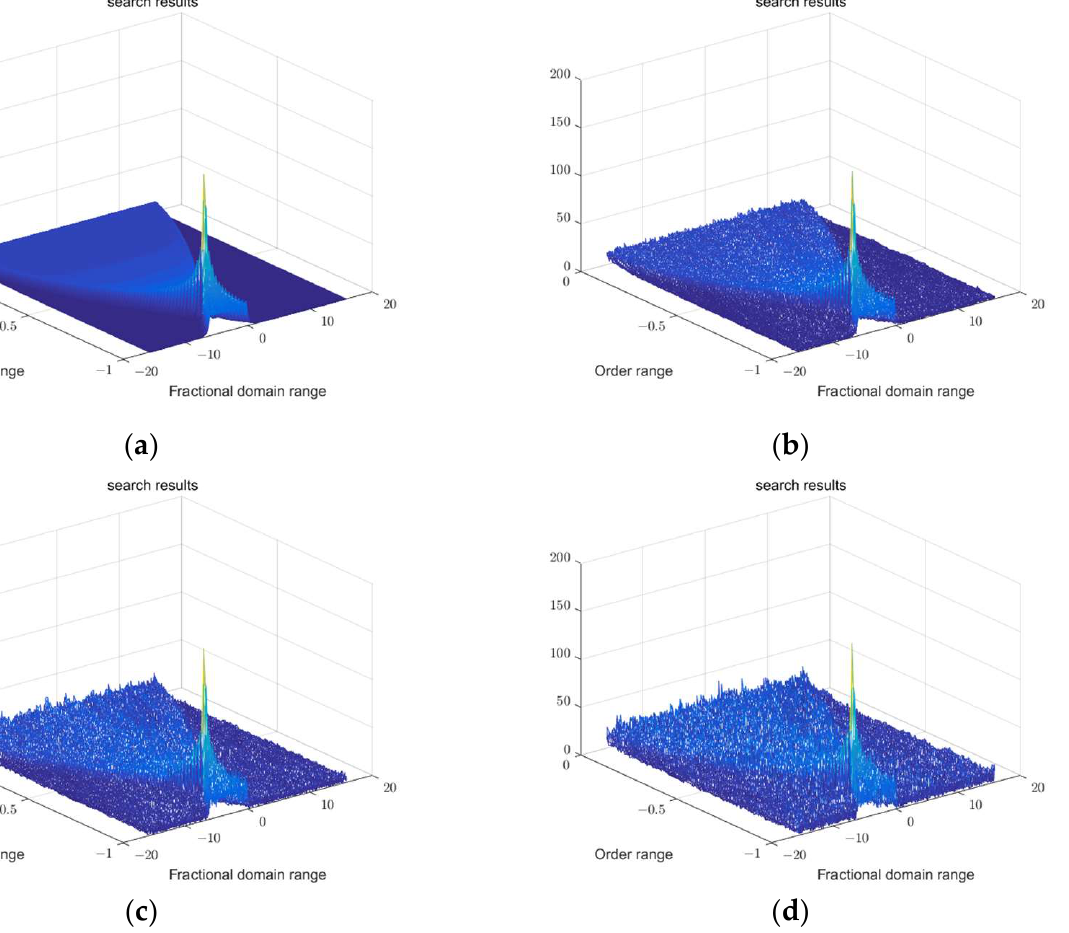
Figure 3. Noise suppression in fractional domain. ( a ) FrFT order search of pure signal; ( b ) FrFT order search of signal when SNR = 10 dB; ( c ) FrFT order search of signal when SNR = 5 dB; ( d ) FrFT order search of signal when SNR = 1 dB.